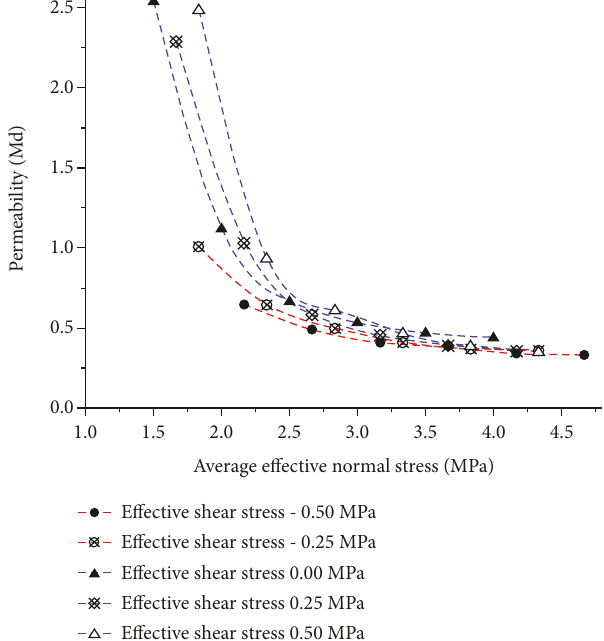
Figure 11: The seepage test results obtained under constant e ff ective shear stress SA3. The test results obtained under constant e ff ective shear and normal stress conditions are depicted in Figures 11 and 12, respectively.